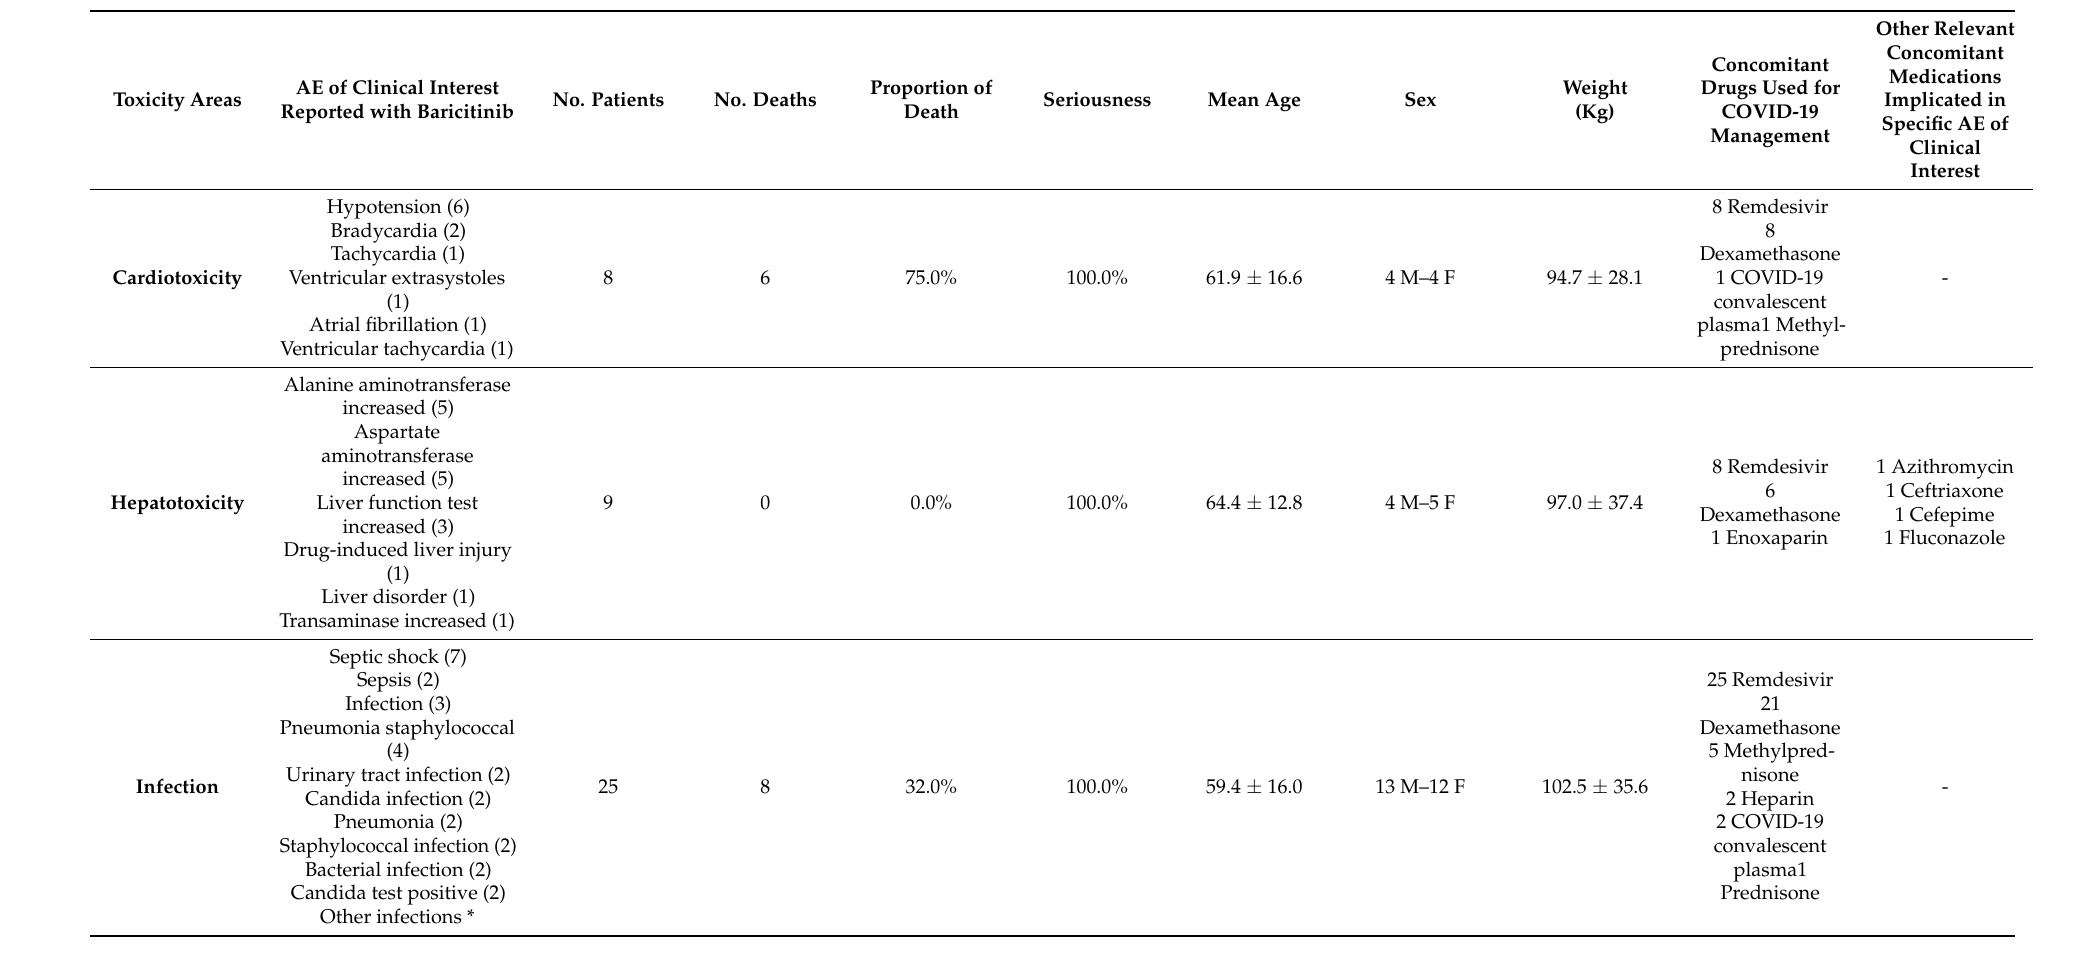
Table 6. Case-by-case assessment of reports concerning adverse events of clinical interest with baricitinib for COVID-19 management.